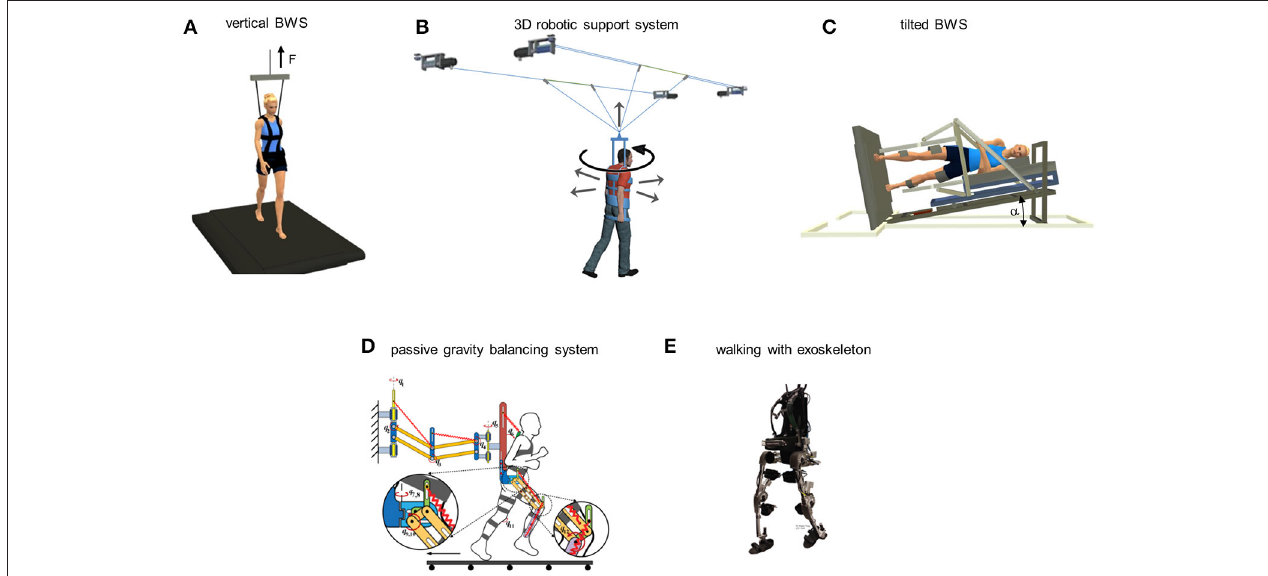
FIGURE 3 | Different classes of reduced gravity simulators for locomotion. (A) vertical body weight support system: subject walks on a treadmill while being supported in a harness, pulled upwards by a preset unloading force F. (B) robotic support system that allows assisted 2D overground locomotion, including the directions of the actuated and passive (rotation) degrees of freedom (adapted from Mignardot et al., 2017). (C) tilted unloading system: subject lies on the side on a tilted couch with both legs suspended in the low friction exoskeleton and steps on the treadmill tilted to the same angle (adapted from Ivanenko et al., 2011). The component of the gravitational force acting on the stance and swing limbs is proportional to the tilting angle α . (D) passive reduced gravity walking simulator (courtesy of Dr. Ou Ma) consisting of the spring-balanced dual-parallelogram mechanism to compensate for the weight of the body and the legs. (E) Mindwalker exoskeleton for assisted walking in spinal cord injured individuals (adapted from Wang et al.,